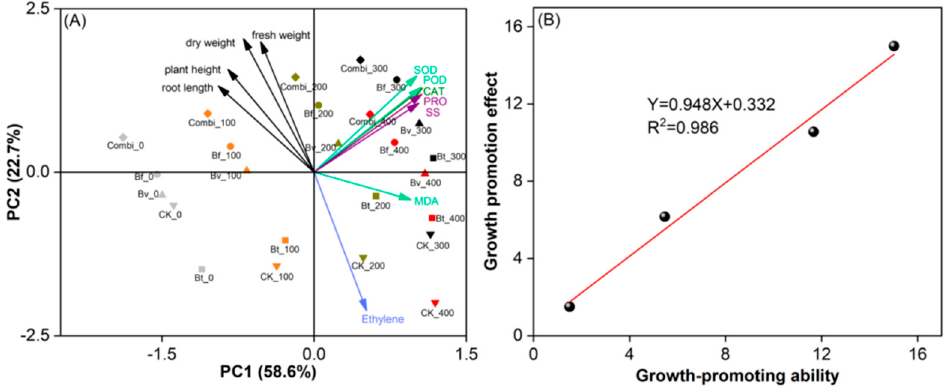
Figure 6. Effect of salt ‐ tolerant plant growth promoting rhizobacteria (ST ‐ PGPR) on the growth ‐ promoting mechanism of wheat was investigated by using ( A ) principal component analysis and ( B ) linear regression analysis.